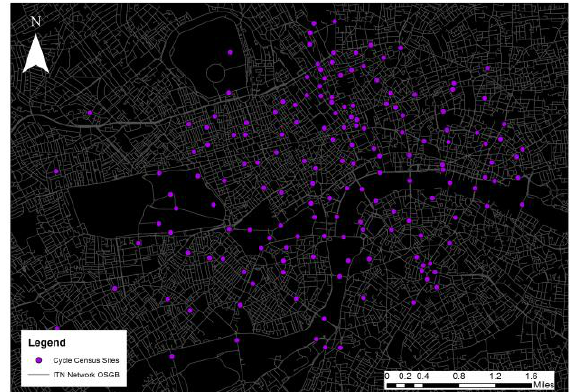
Figure 1. Map of the CC locations and